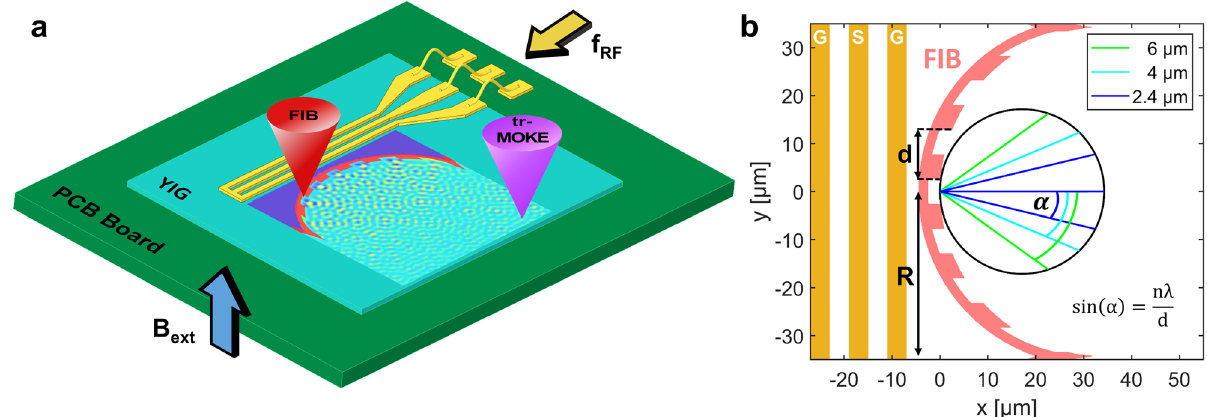
Figure 1. ( a ) Sketch of the experimental setup, indicating the coplanar waveguide, the FIB irradiated grating, the trMOKE probing laser, and the spin-wave interference pattern. ( b ) Geometry of the curved diffraction grating in the Rowland arrangement. The angle under which the first-order diffraction peak is seen from center of the grating is denoted by α